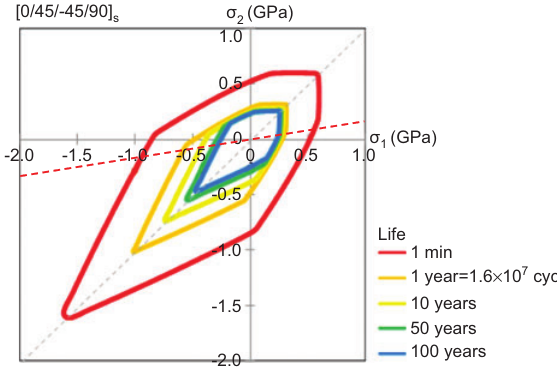
Figure 19 Fatigue failure envelope in σ life for π /4 [0/45/-45/90]